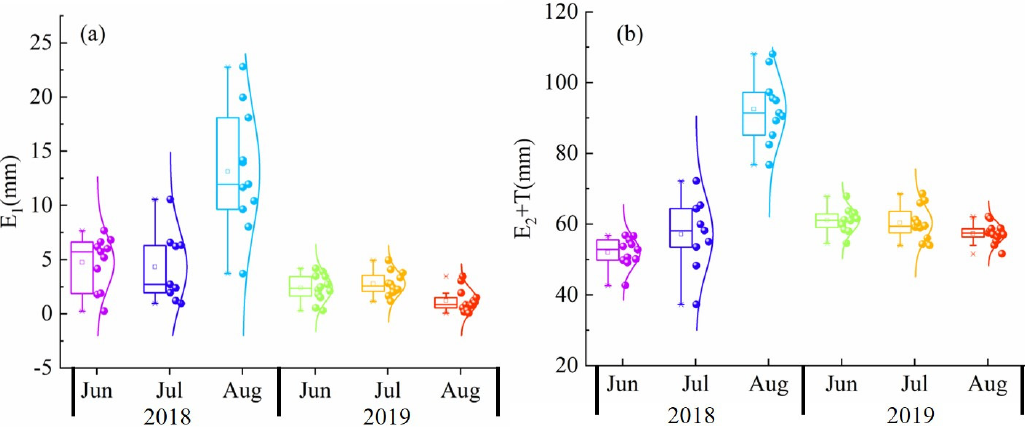
Figure 2. Temporal variation in soil fractionation values ( E 1 ) ( a ) and incomplete evaporation values ( E 2 + T ) ( b ) in the summer of 2018 and 2019.